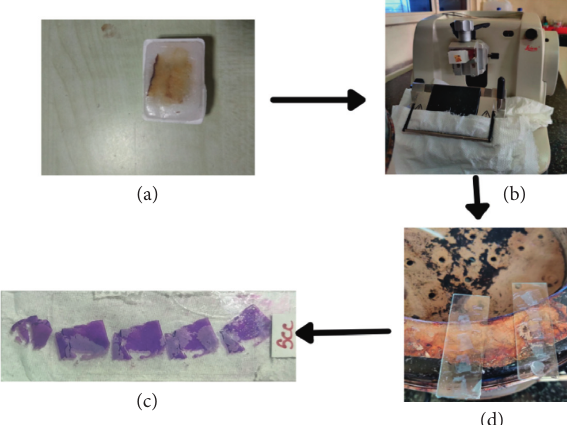
Figure 3: (a) Paraffin blocks with tissues. (b) Microtome. (c) Slide without stain. (d) Slide with H&E stain.